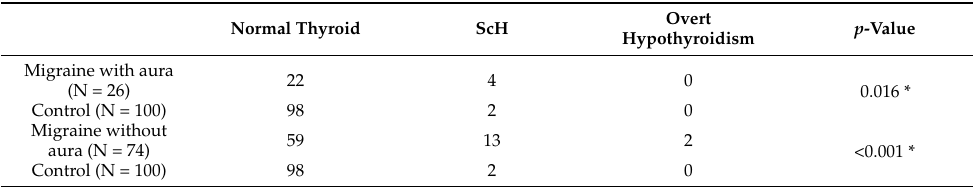
Table 4. Subgroup analysis of thyroid function, comparing migraine with aura and migraine without aura vs. controls.